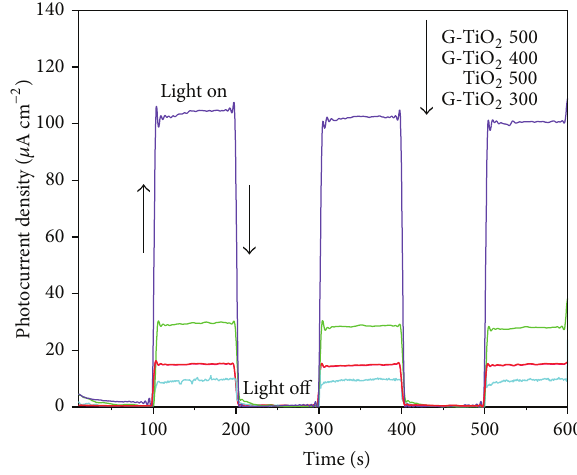
Figure 9: Photocurrent response of TiO 2 and G-TiO 2 electrodes to ON-OFF cycles of UV